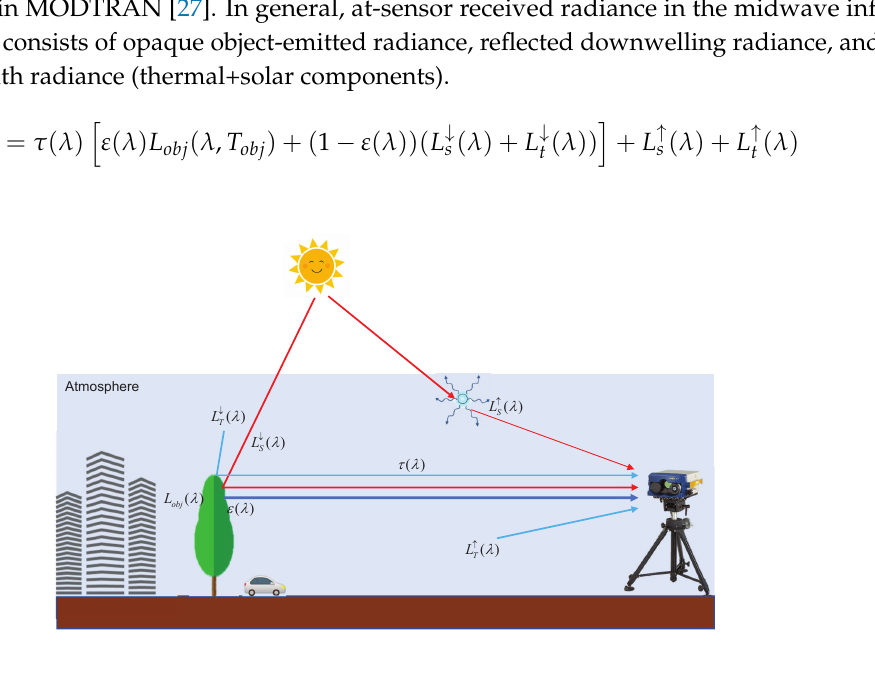
Figure 7. Operational concept of visual air temperature (VisualAT) measurement using the passive open path Fourier transform infrared (FTIR) imaging